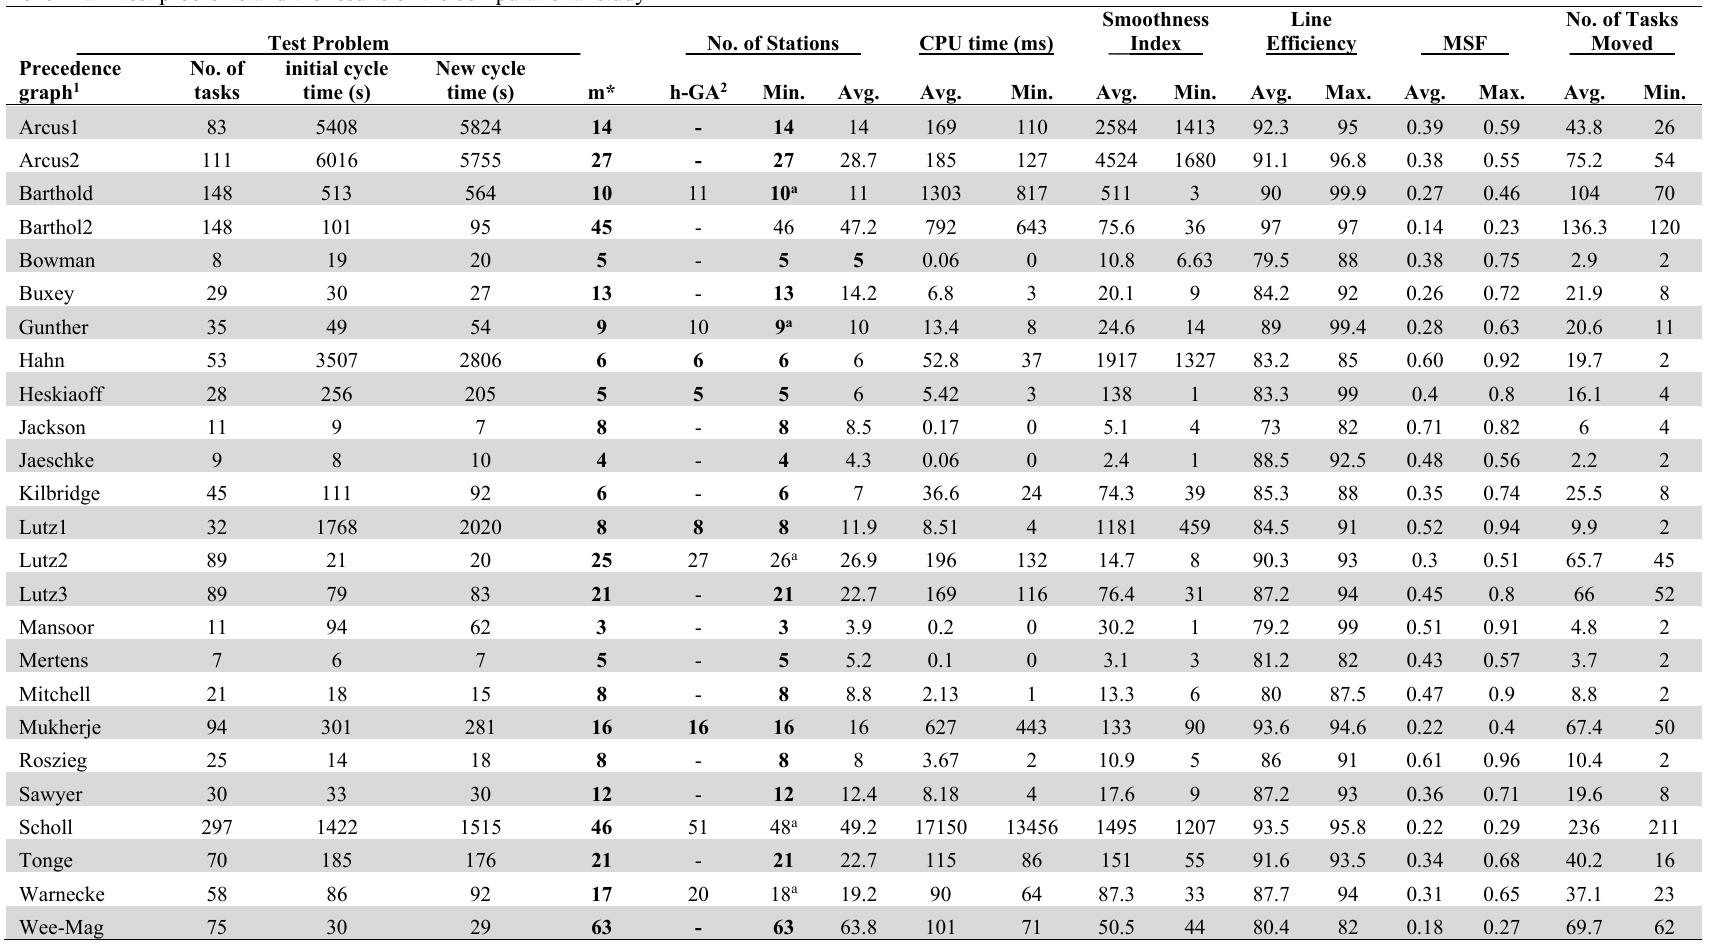
Benchmark test problems and the results of the computational